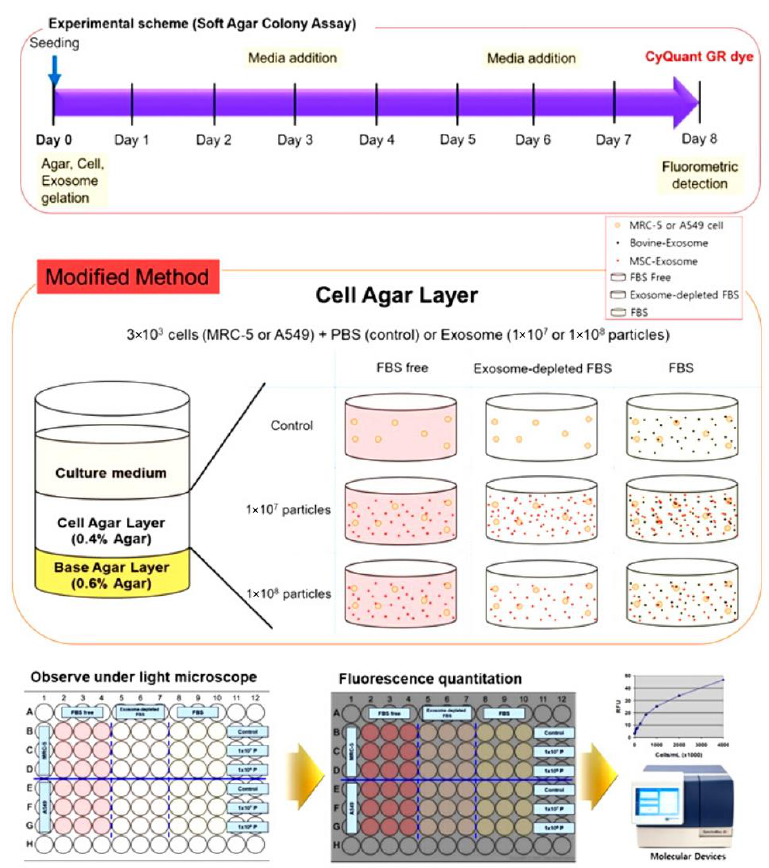
Figure 2. Experimental design of soft agar colony formation assay in vitro. For in vitro tumorigenicity test of EVs, MRC-5 and A549 cells (3 × 10 3 cells/well) are divided into three groups (FBS Free, exosome-depleted FBS, and normal FBS contained well) and each group is assigned a PBS-treated control group. The EVs are incubated with cells on the cell agar layer as shown in the diagram, and the medium is replaced every 3 days. On the 8th day of culture, the agar is solubilized to dissolve both agar and cells, and after treatment with CyQuant GR dye, fluorescence is measured at 485/520 nm to determine whether colony formation increased. FBS, fetal bovine serum; PBS, phosphate-buffered saline.